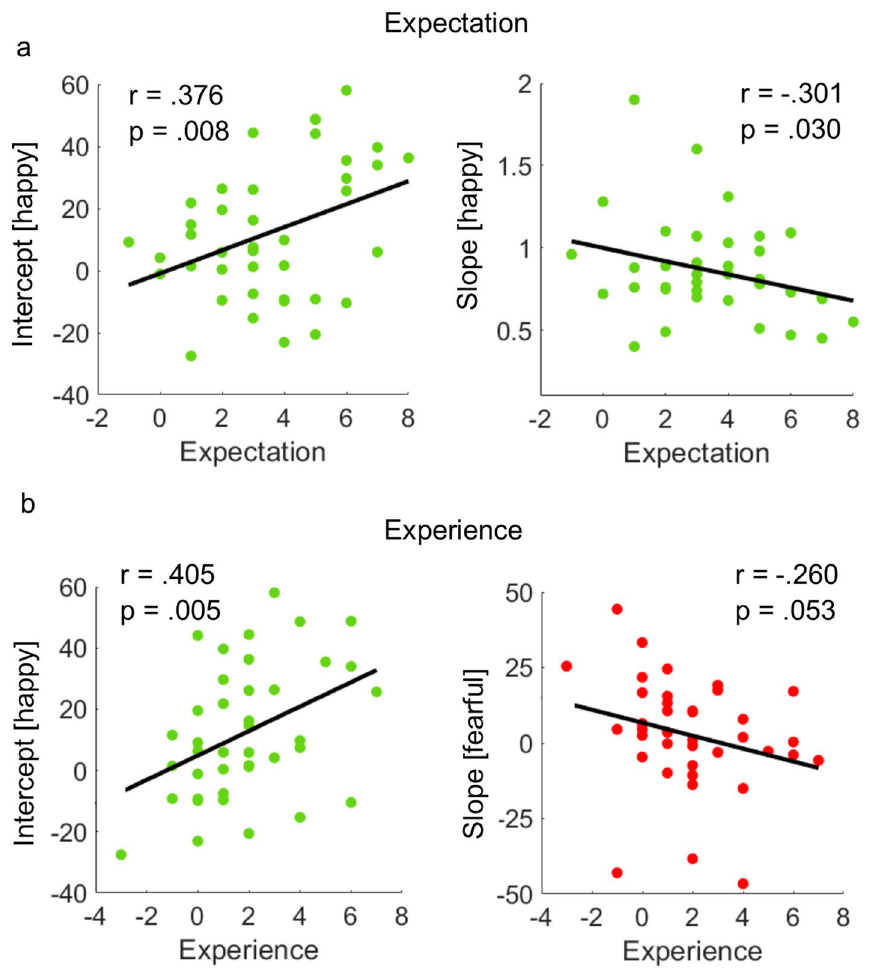
Figure 6. Correlations between self-reports and emotion classification measures. ( a ) Participants who reported a higher positive mood expectation, presented a more liberal response criterion (left) and reduced sensitivity (right) for happy expressions. ( b ) Participants who reported a higher positive mood experience presented a more liberal response criterion for happy expressions (left), and tended to apply a more strict response criterion for fearful expressions